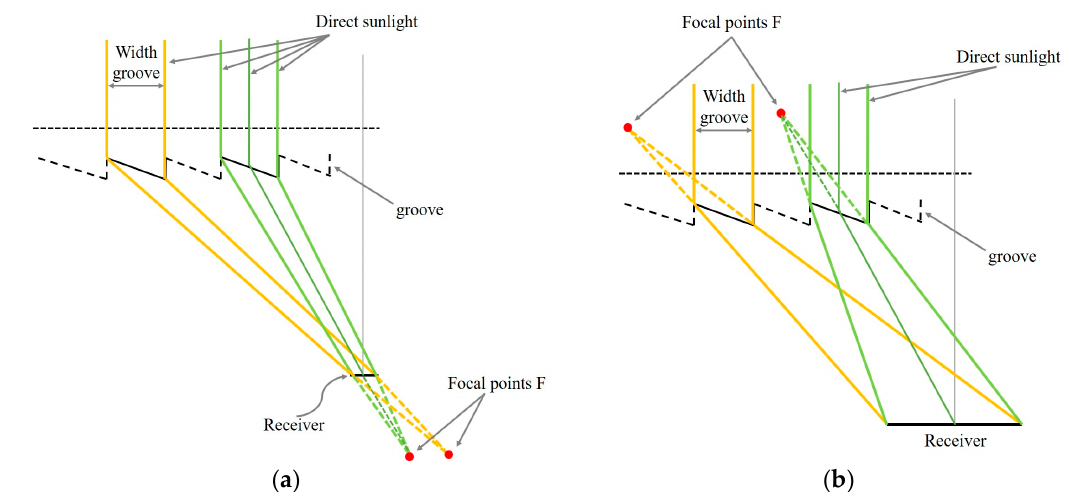
Figure 7. The irradiance distribution in the conventional design of the Fresnel lens, in which there is only one focal point at the center of the receiver.